Question: Generate an informative caption for the figure above.
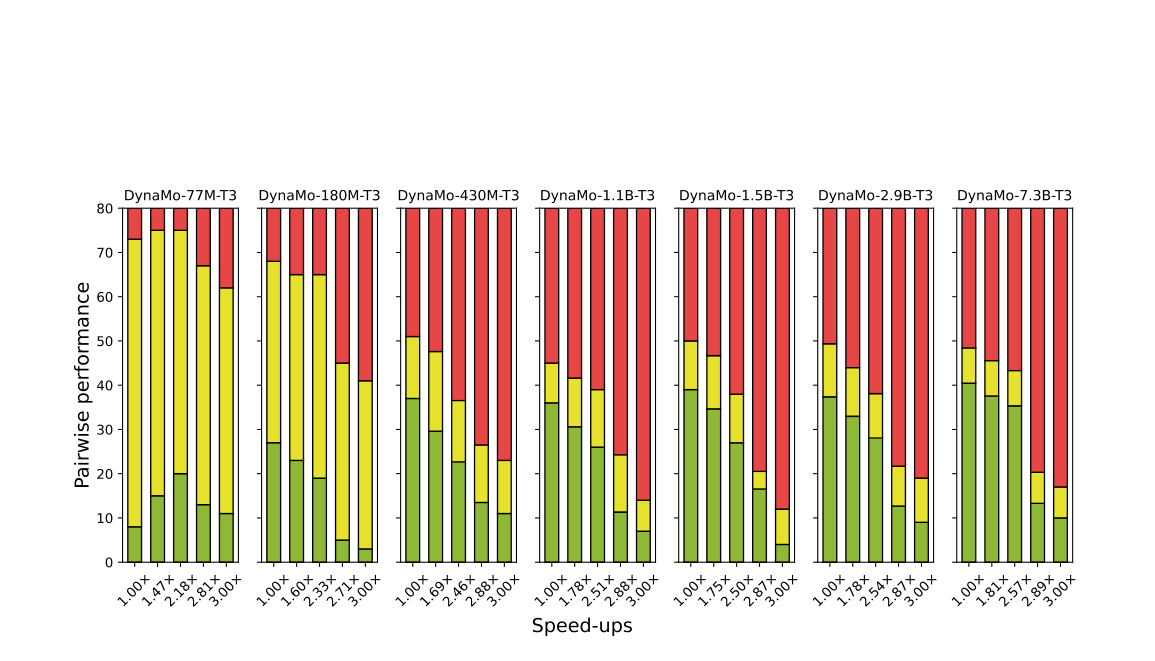
Answer: Pairwise performance of the DynaMo and Pythia models on the Vicuna benchmark. GPT-4 was used as a judge. The actual number of wins, ties, and losses are colored green, yellow, and red, respectively.